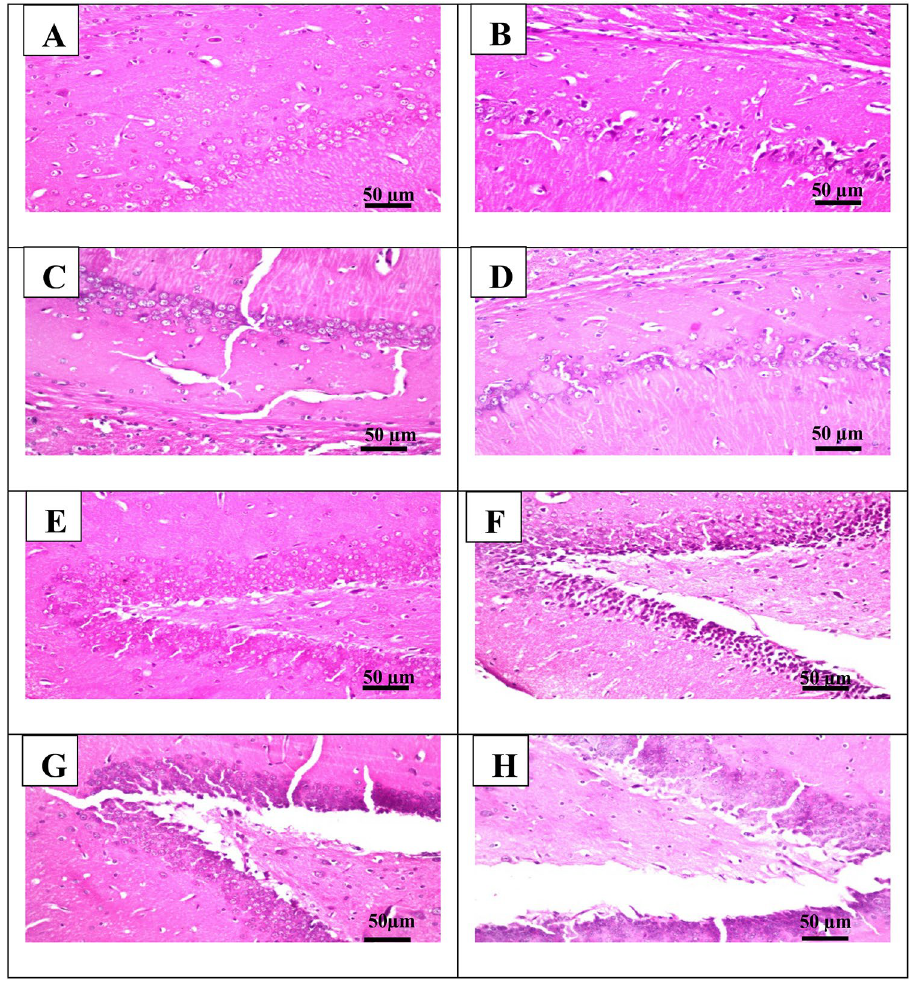
Figure 8. Representative photomicrographs (H&E, × 200) of (A) section from the subiculum of the control group, (B) section from the subiculum of the cyclophosphamide, (C) section from the subiculum of lutein 50 group, (D) section from the subiculum of lutein 100 group, (E) section from the fascia dentata and hilus of the control group, (F) section from the fascia dentata and hilus of cyclophosphamide group, (G) section from the fascia dentata and hilus of lutein 50 group, and (H) section from the fascia dentata and hilus of lutein 100